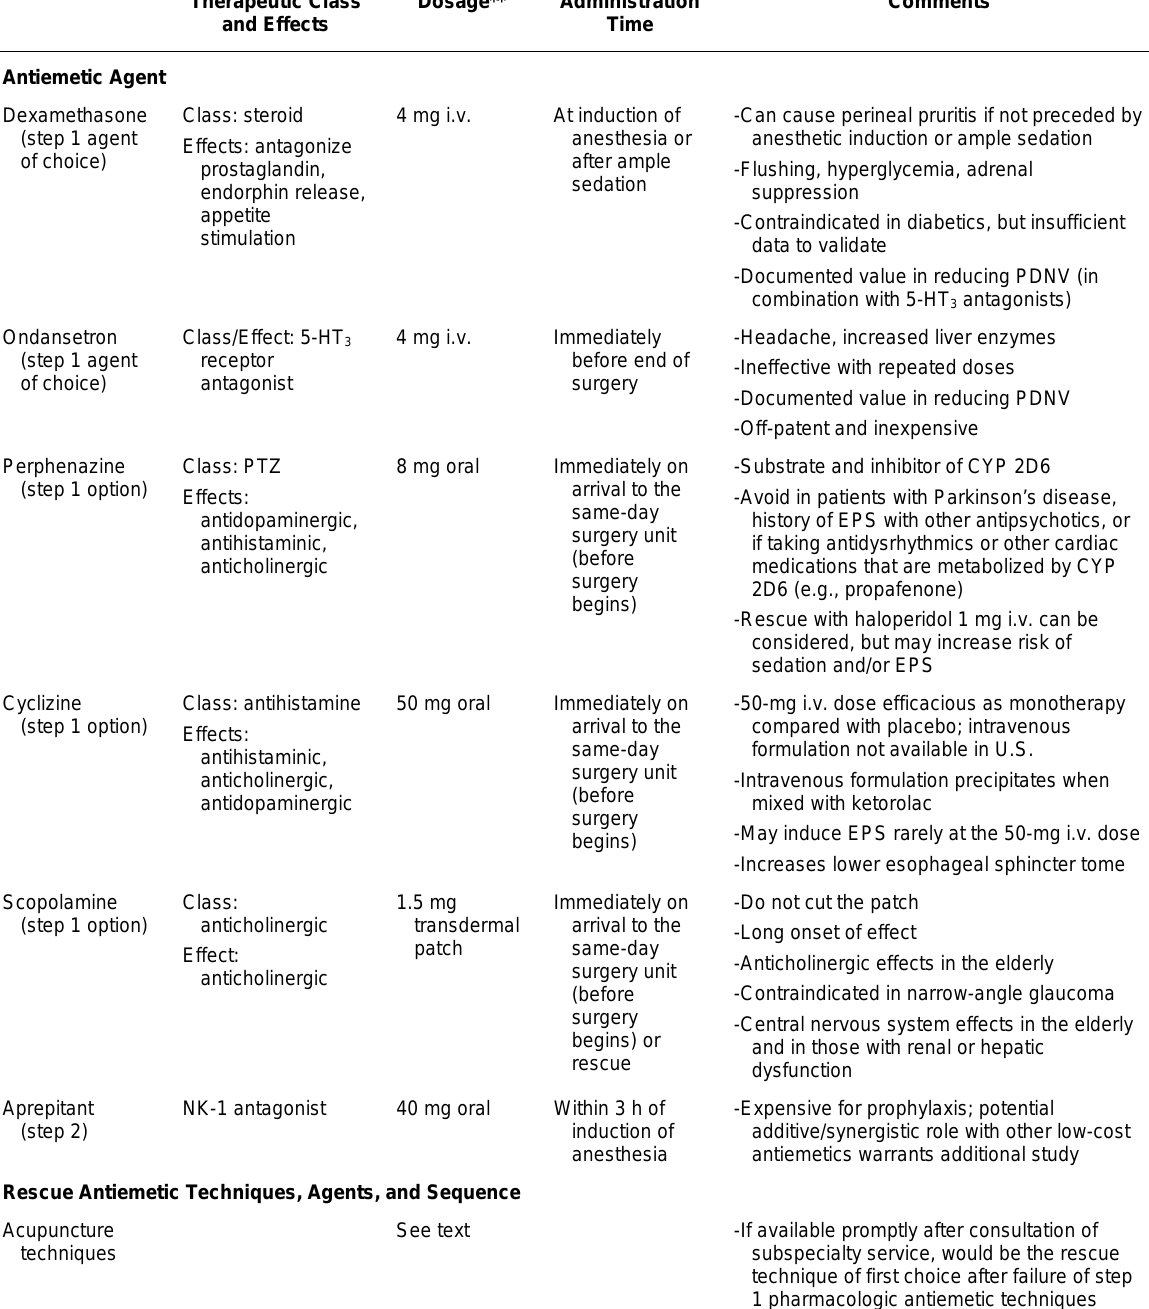
Dosing Information for Multimodal Antiemetic Prophylaxis and Rescue in Adult Surgical Outpatients* (Based on the Agents Described in Fig. 2; Applicable to Nonparturients, Adults Less than 70 Years Old**, and Not Undergoing Cataract